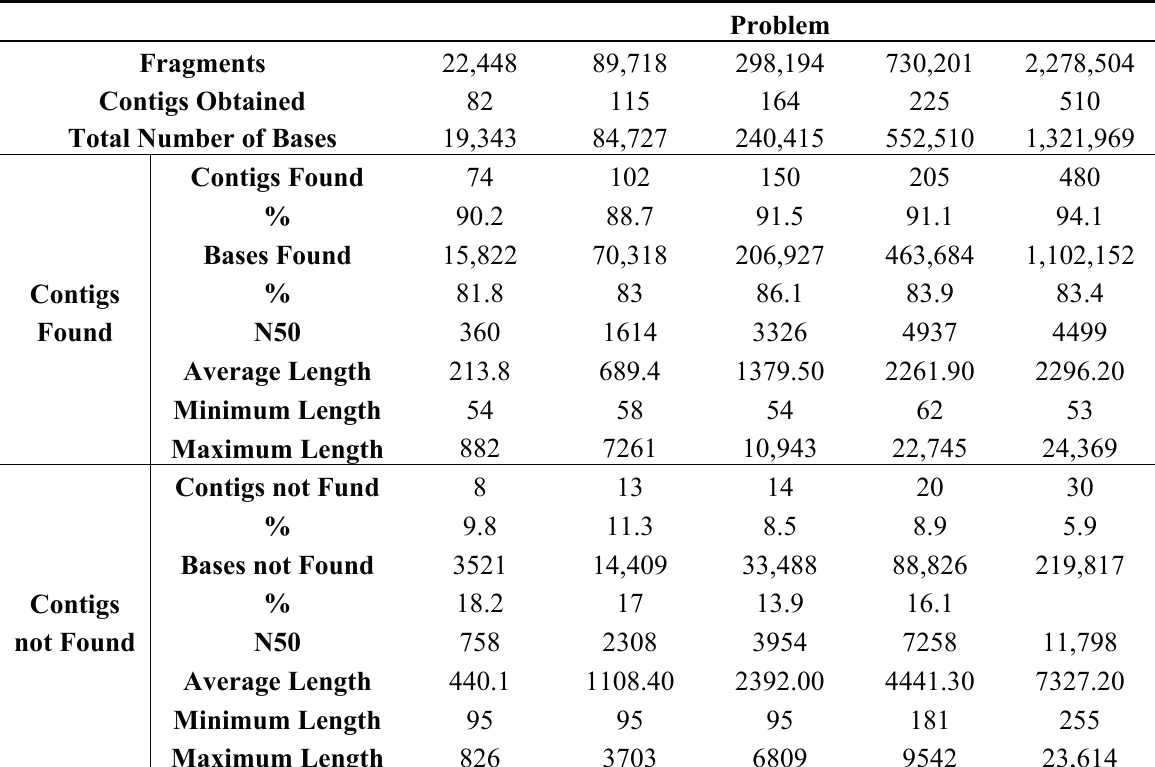
Table 11. Algorithm 5, F 1 objective function, no transitive